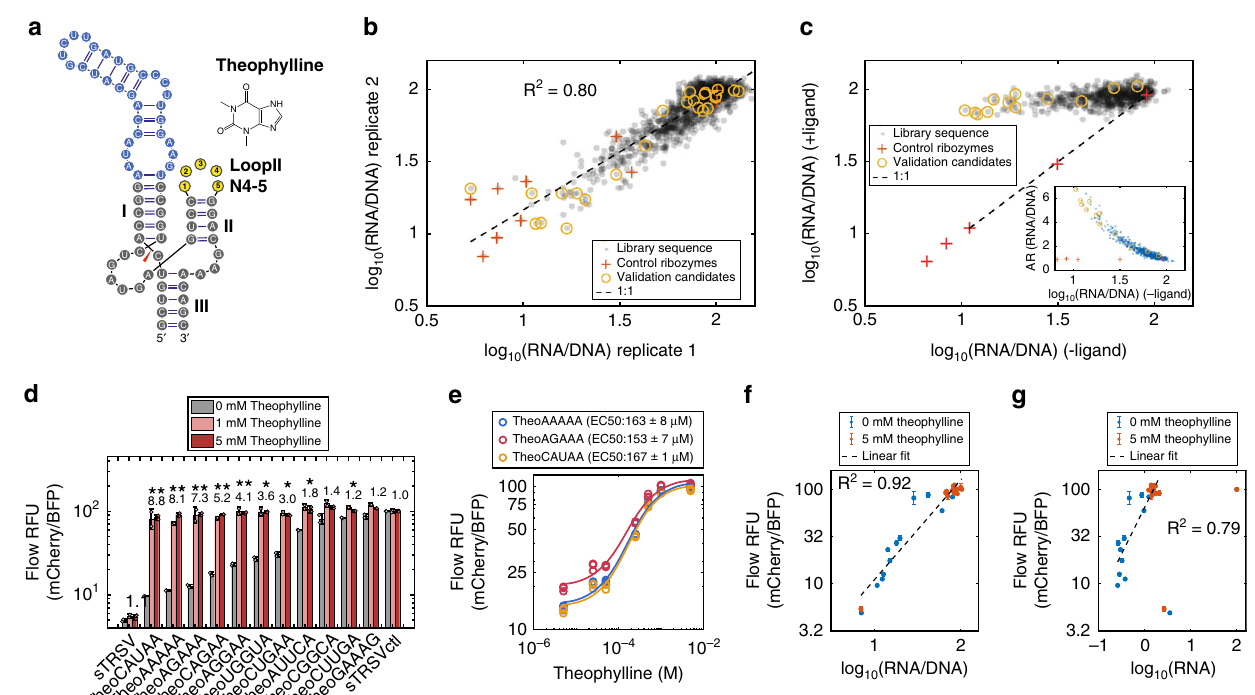
Fig. 2 RNA-Seq assay for a theophylline ribozyme switch library. a Illustration of a theophylline ribozyme switch library design. b Normalized RNA read counts from replicate RNA-Seq experiments ( R 2 = 0.80). Each dot represents a unique sequence with over 100 sequencing read counts in an experiment (665 sequences). Pluses are spiked-in control ribozymes; circles indicate sequences selected for validation. c Normalized RNA read counts from an RNA- Seq assay performed on a theophylline ribozyme switch library in the absence and presence of ligand. The inset shows the activation ratio (AR) as a function of normalized RNA read counts in the absence of ligand. − / + Ligand conditions are 0/5 mM theophylline. d Flow cytometry analysis of individual members in the theophylline ribozyme switch library. Activation ratio (AR) of mCherry/BFP at the higher ligand concentration is indicated above each set of bars. sTRSV is the wild-type hammerhead ribozyme; sTRSVctl is a non-cleaving mutant of sTRSV; error bars indicate standard deviation of two biological replicates; asterisks indicate the Benjamini – Hochberg corrected p -values of switching signi fi cance between 0 and 5 mM theophylline, using p -values from unpaired, one-tailed t -test, * p < 0.01, ** p < 0.001. Filled circles are individual replicate data points. e Dose response curves for three theophylline switches showing relative fl uorescence values as a function of theophylline concentration. EC50 values are reported as mean ± standard deviation of three biological replicates. f Relative fl uorescence values from fl ow cytometry analysis of individual sequences plotted against normalized RNA read counts from an RNA- Seq assay ( R 2 = 0.92). Error bars indicate standard deviation of two biological replicates. g Relative fl uorescence values from fl ow cytometry analysis